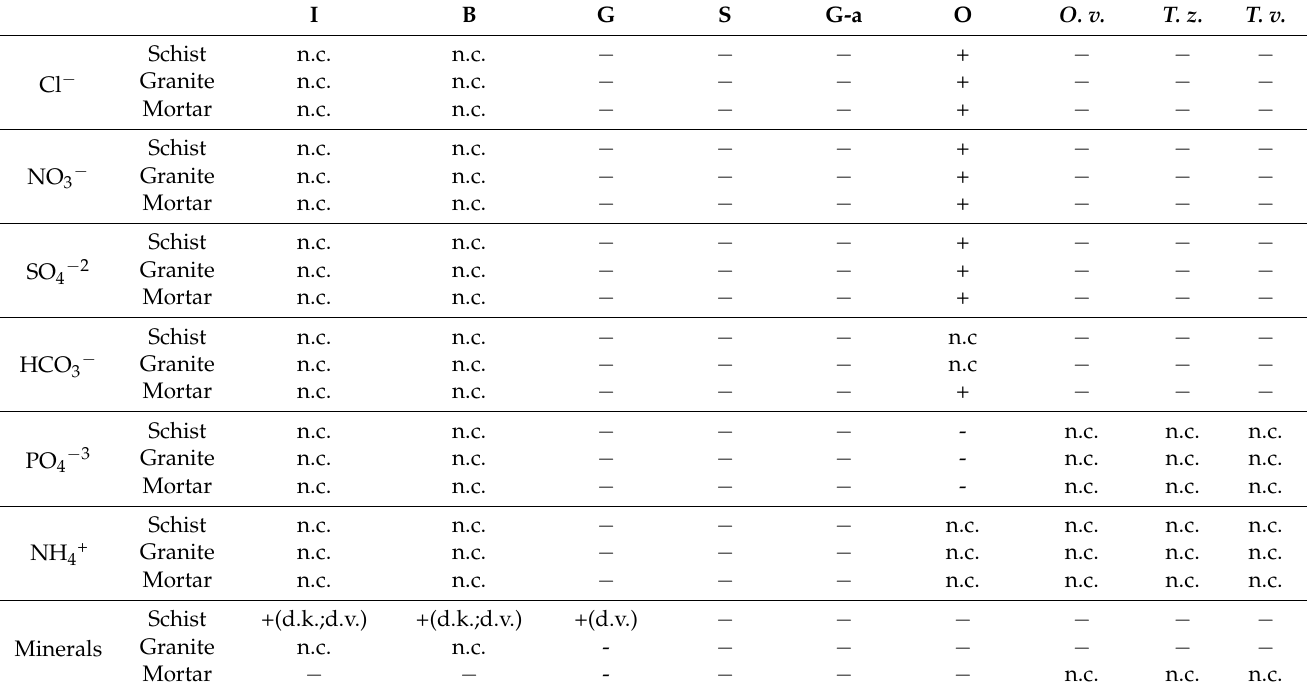
Table 5. Changes in the ion content and the mineral composition. +: change detected; − : no change detected; n.c.: not considered; d.k.: disappearance of kaolinite; d.v.: disappearance of vermiculite. I B G S G-a O O. v. T. z. T. v. Schist n.c. n.c. − − − + − − − Granite n.c. n.c. − − − + − − − Cl − Mortar n.c. n.c. − − − + − − − Schist n.c. n.c. − − − + − − − Granite n.c. n.c. − − − + − − − NO 3 − Mortar n.c. n.c. − − − + − − − Schist n.c. n.c. − − − + − − − Granite n.c. n.c. − − − + − − − SO 4 − 2 Mortar n.c. n.c. − − − + − − − Schist n.c. n.c. − − − n.c − − − Granite n.c. n.c. − − − n.c − − − HCO 3 − Mortar n.c. n.c. − − − + − − − Schist n.c. n.c. − − − - n.c. n.c. n.c. Granite n.c. n.c. − − − - n.c. n.c. n.c. PO 4 − 3 Mortar n.c. n.c. − − − - n.c. n.c. n.c. Schist n.c. n.c. − − − n.c. n.c. n.c. n.c. Granite n.c. n.c. − − − NH 4+